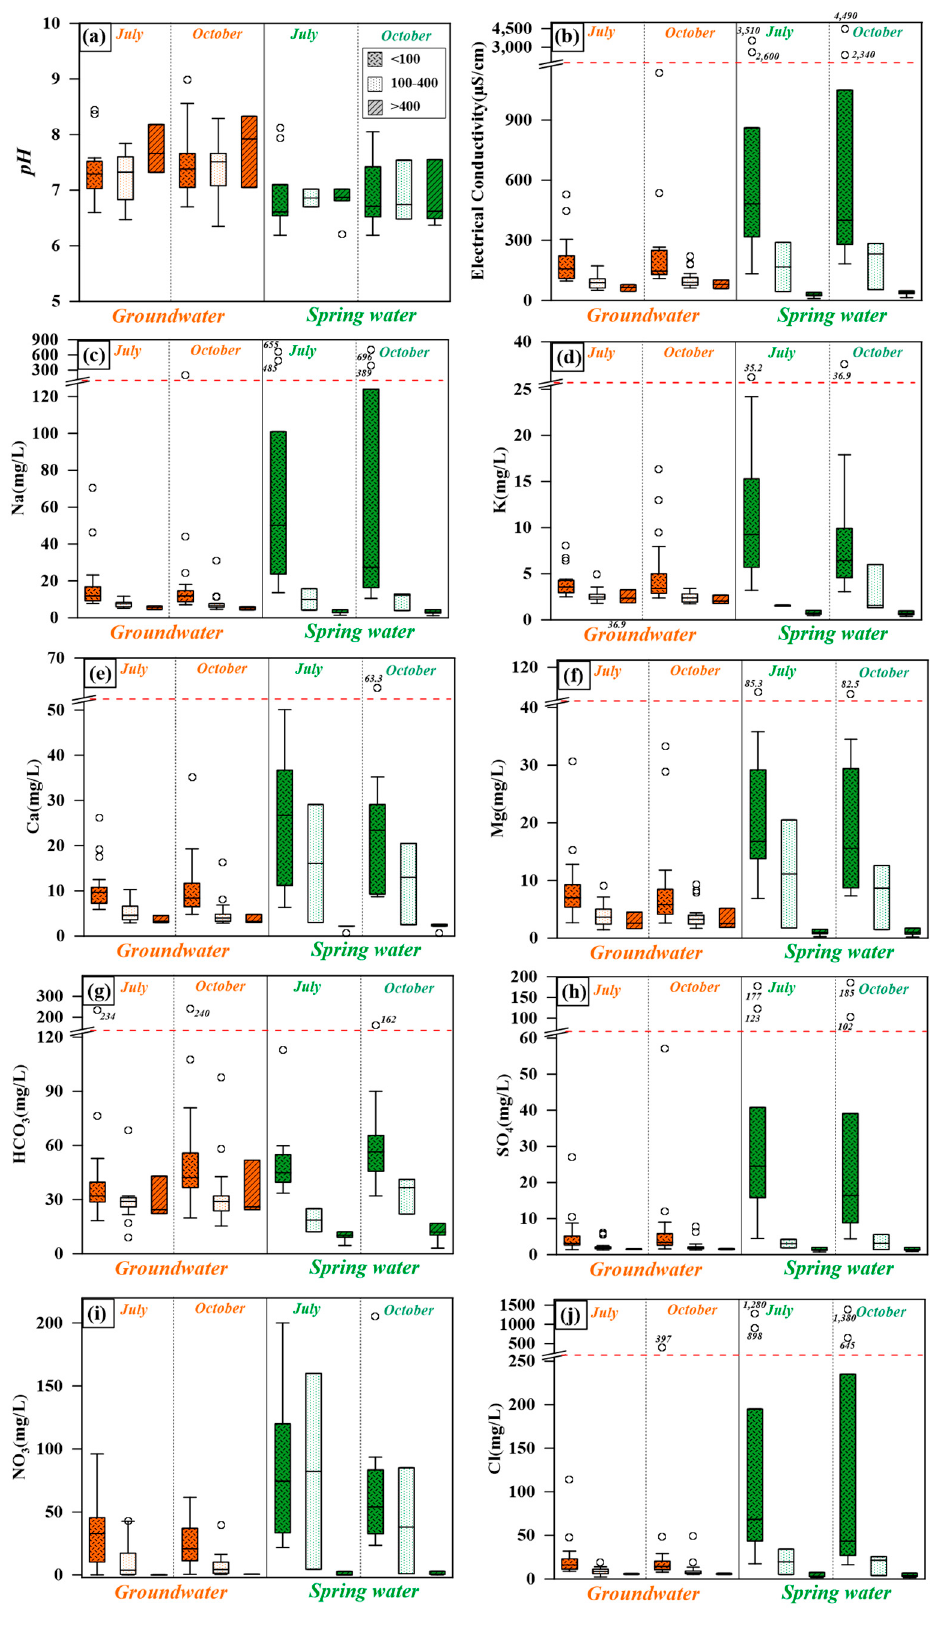
Figure 3. Box-whisker statistical diagrams of pH, electrical conductivity and major ions of groundwater and spring water in Jeju Island. ( a ), ( b ), ( c ), ( d ), ( e ), ( f ), ( g ), ( h ), ( i ) and ( j ) are the variation of pH, EC, Na, K, Ca, Mg, HCO 3 , SO 4 , NO 3 and Cl as a function of altitude, respectively.